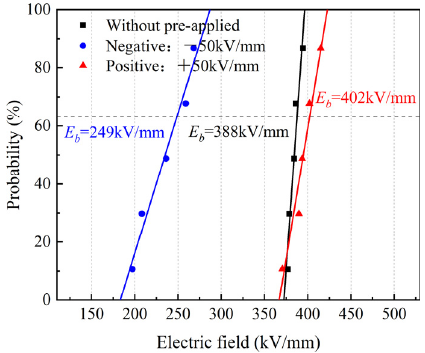
Figure 8. Weibull distribution of breakdown strength of PP. Table 1. Parameters for breakdown behavior.